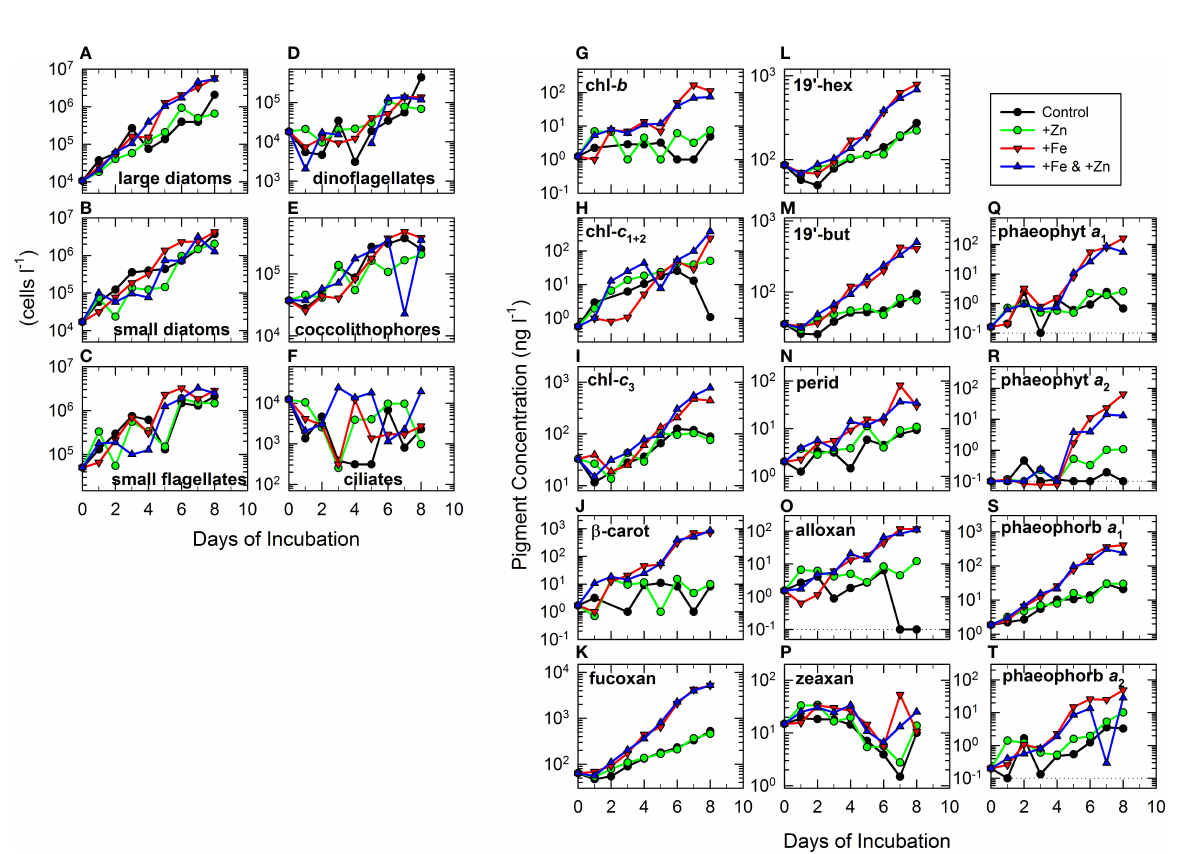
FIGURE 2 Time series of measurements of microplankton community composition from each of the cubitainers described in Figure 1. Abbreviations given in Table 1A. Abundance (cells L − 1 ) of several broad taxonomic groups of phytoplankton: (A) large diatoms, (B) small diatoms, (C) small fl agellates, (D) dino fl agellates, (E) coccolithophores, and (F) ciliates. Concentrations of pigments (ng L − 1 ) measured using high-pressure liquid chromatography (HPLC) analysis of particulate samples. See Methods for details. Pigments shown are (G – I) chlorophylls chl- b , chl- c 1+2 , and chl- c 3 ; (J) the carotenoid b -carot and several xanthophyll carotenoids; (K) fucoxan; (L) 19 ’ -hex; (M) 19 ’ -but; (N) perid; (O) alloxan; and (P) zeaxan. Also shown are chlorophyll degradation derivatives (Q, R) phaeophyt a 1 and a 2 , and (S, T) phaeophorb a 1 and a 2 . Because of the log- scale plots, where pigments were undetectable, the lower detection limit of ~0.1 ng L − 1 (see dotted line where appropriate) of the pigment was also